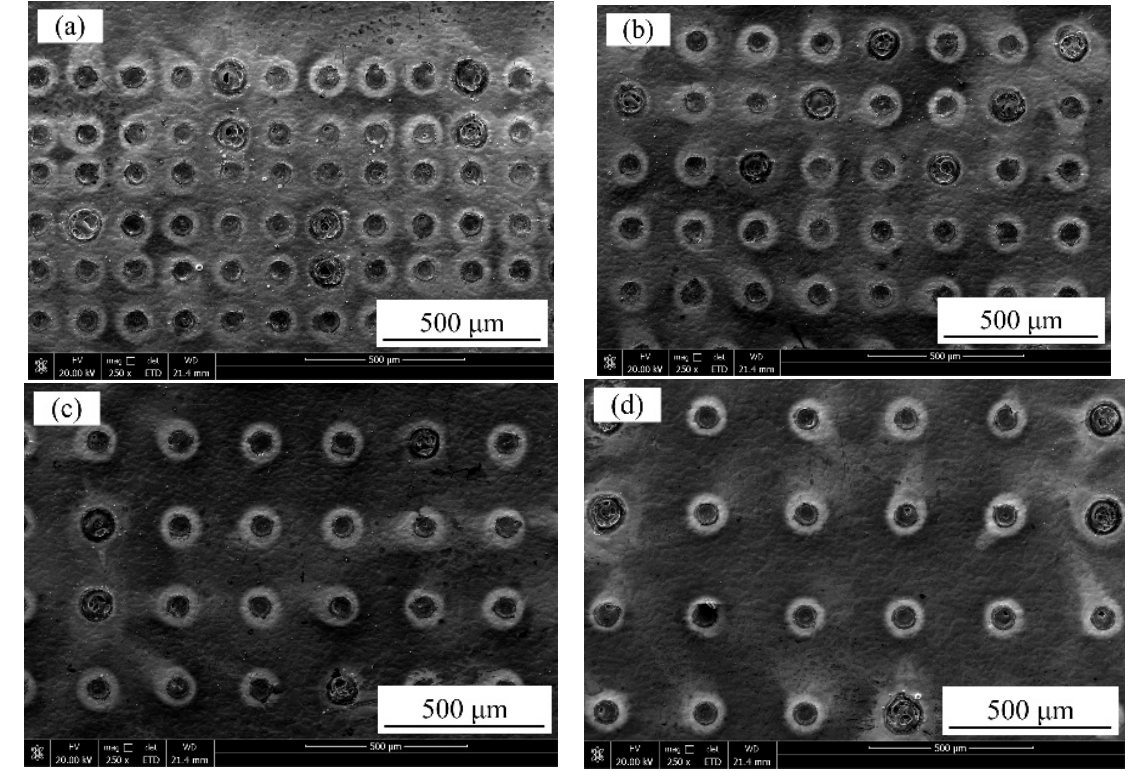
Figure 14. SEM images of textured surface with varying spot-to-spot distance: ( a ) 150 µm; ( b ) 200 µm; ( c ) 250 µm; ( d ) 300 µm.